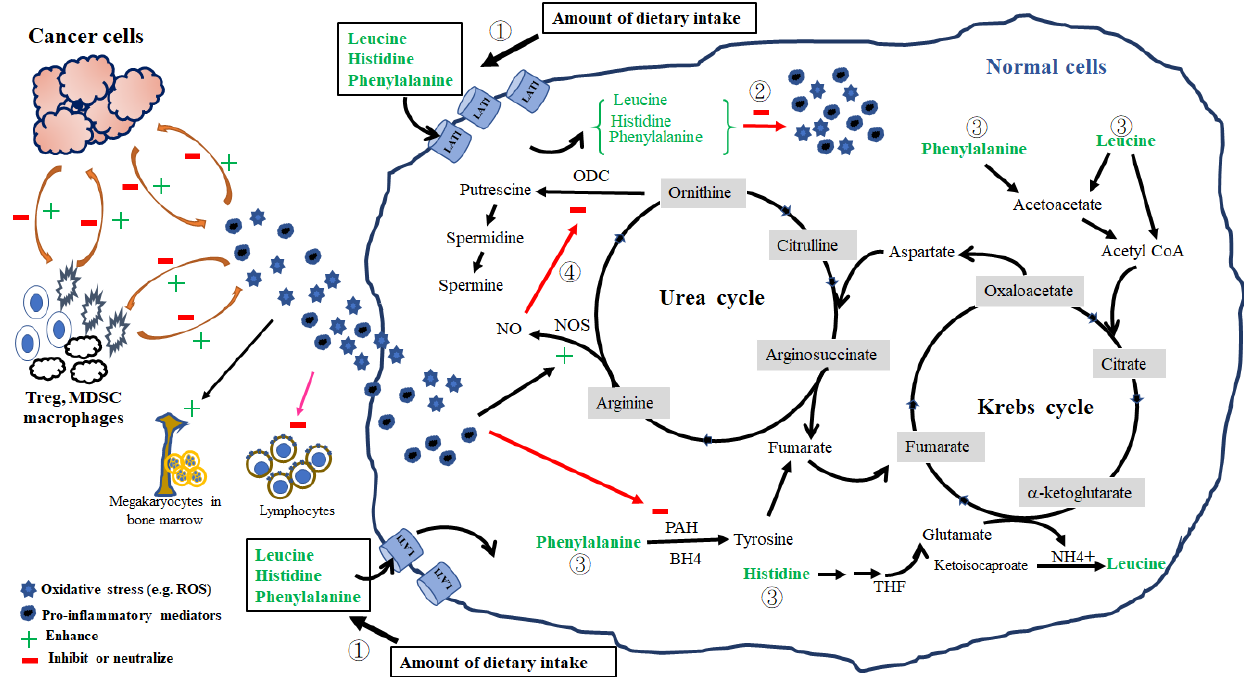
Figure 2. Four possible mechanisms responsible for serum levels of histidine, leucine, ornithine, and phenylalanine in patients with LAHNSCC before concurrent chemoradiotherapy. They include: amount of dietary intake ( ① ), consumption in the neutralization against oxidative and pro-inflam- matory stress ( ② ), fuel provider for energy production ( ③ ), and nitric oxide synthase (NOS)–nitric oxide (NO) pathway ( ④ ). First, reduced dietary intake directly results in decreased serum levels of essential amino acids (histidine, leucine, and phenylalanine). Second, essential amino acids are de- livered into cells via L-type amino acid transporter 1 (LAT1); once inside, they can neutralize the reactive oxygen species (ROS) and pro-inflammatory mediators using their antioxidative and anti- inflammatory activities or enter into the Krebs cycle for energy production to compensate calorie deficiency from inadequate food intake. Finally, ROS and pro-inflammatory mediators can stimu- late thrombopoiesis from mature megakaryocytes in the bone marrow, inhibit lymphocyte differ- entiation and proliferation, and upregulate NOS and NO production. Produced NO can decrease ornithine decarboxylase (ODC) activity and increase the ornithine levels. The magnitude of oxida- tive stress and pro-inflammatory mediators are reciprocally regulated by cancer and immune cells, such as regulatory T cells (Treg), macrophages, and myeloid-derived suppressor cells (MDSC), within the tumor microenvironment and in the peripheral blood. ROS and pro-inflammatory medi- ators can reduce the function of phenylalanine hydroxylase (PAH) and prevent the conversion of phenylalanine to tyrosine. Tetrahydrobiopterin (BH4) and tetrahydrofolate (THF) are essential co- factors for the conversion of phenylalanine into tyrosine and histidine into glutamate, respectively. Some intriguing issues merit further investigation. First, the superiority of the GPS and mGPS in prognostic prediction has been compared and debated in several cancer types, including HNC [89–94]. However, the results failed to provide a consensus. The major difference between the GPS and mGPS is the risk classification of patients with hy- poalbuminemia without an increased CRP levels; these patients are considered an inter- mediate-risk group in GPS (GPS 1), while they are at low risk in mGPS (mGPS 0). Alt- hough mGPS can be a useful prognostic biomarker in patients with HNC in various clin- ical scenarios [23,25,26,94,95], mGPS classification showed results similar to GPS (Tables S2 and S3), and the systemic inflammation indicated by CRP levels led to escalated protein breakdown and subsequent hypoalbuminemia [96–98]. In this study, we still preferred GPS to mGPS due to following reasons. First, patients with HNC developed hypoalbu- minemia, probably due to diet intake problems and essential amino acid insufficiency